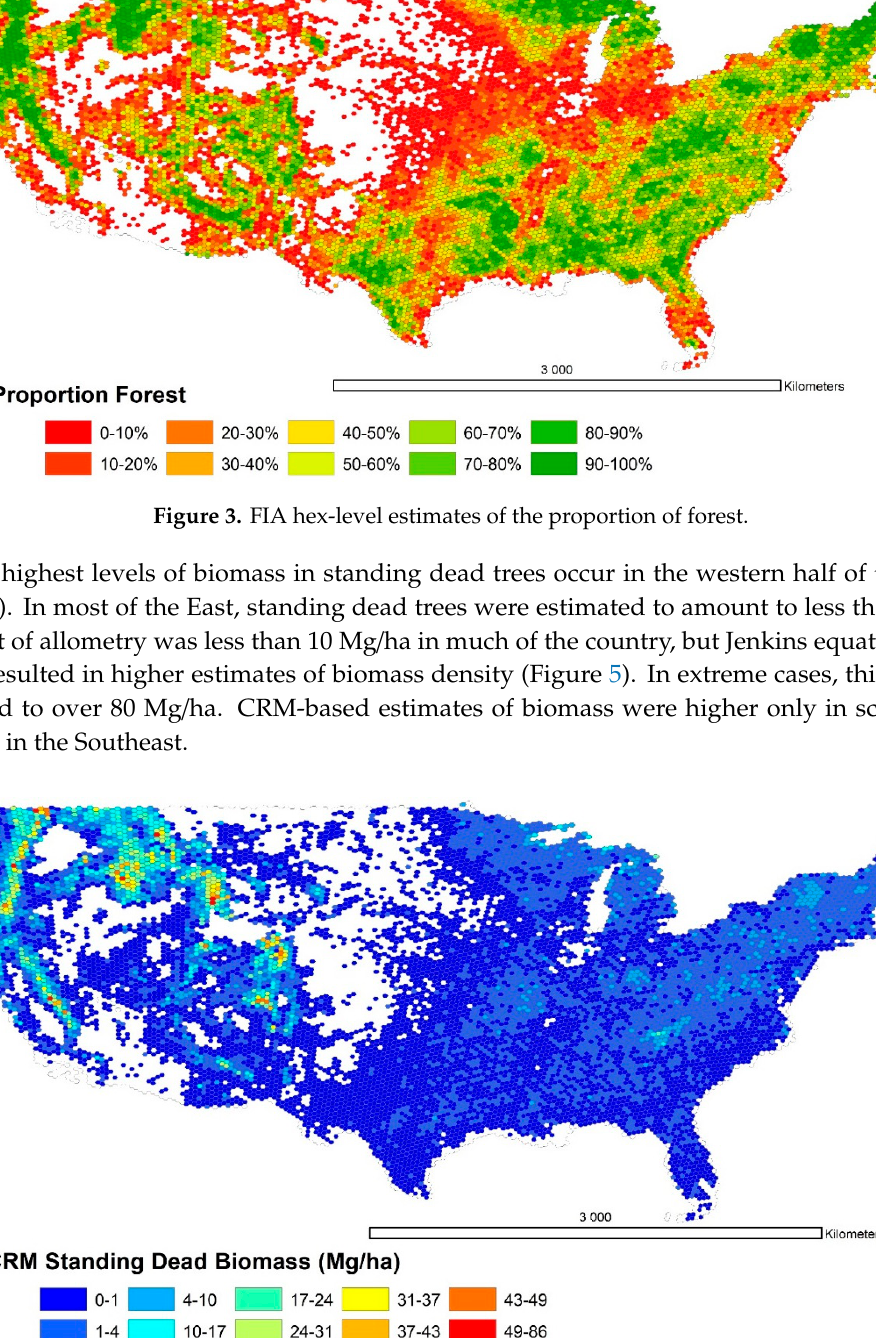
Figure 2. FIA hex-level estimates of the standard error of mean CRM biomass.